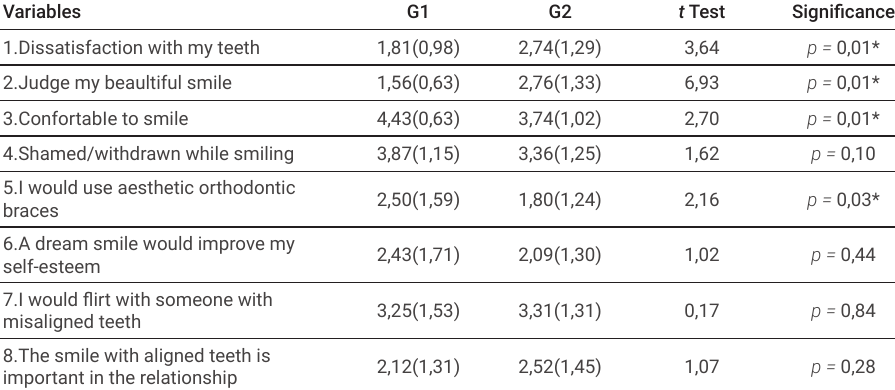
Table 3. Variables, mean and standard deviation, T-test. p-value between G1XG2 from March to December 2018 Variables